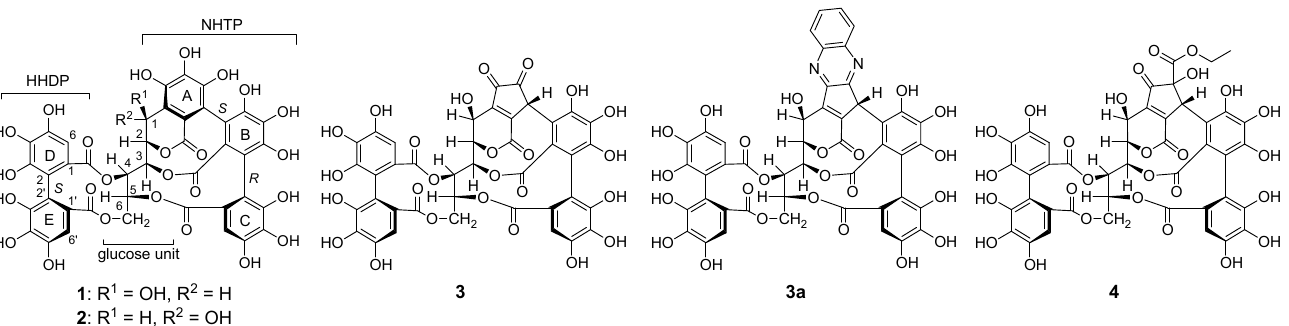
Figure 1. Structures of oak ellagitannins 1 and 2 and oxidation products 3 and 4 .